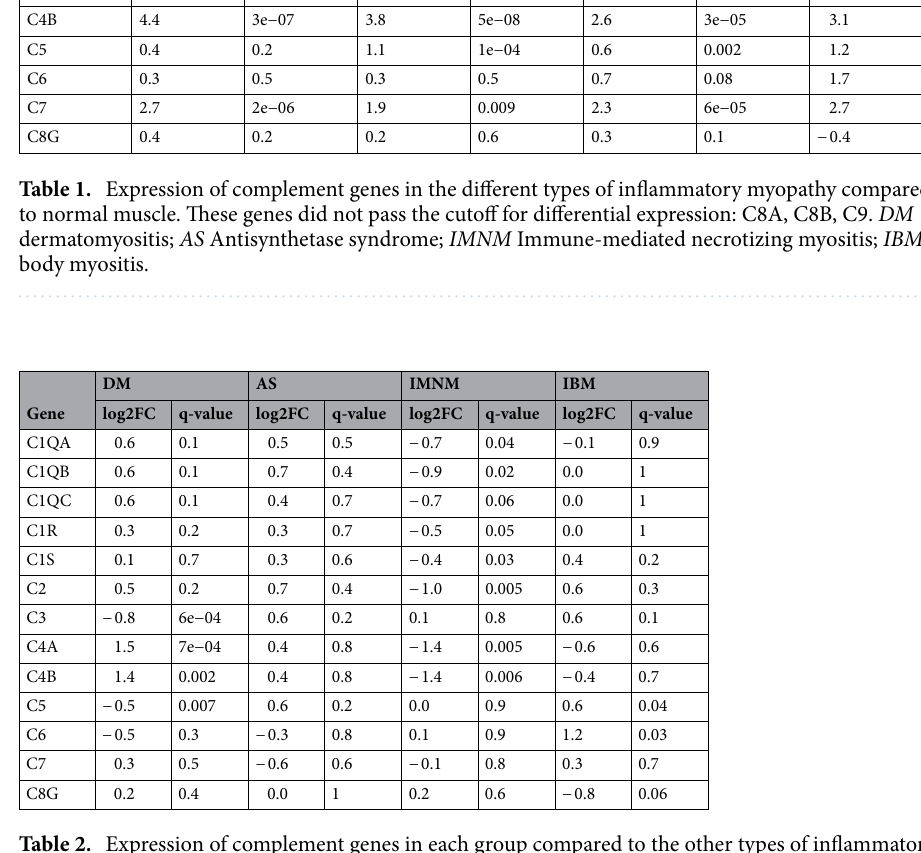
Fig. 5, transcriptomic data from single-nuclei could be used to identify clusters of cells representing mature muscle fibers, satellite cells (i.e., muscle cell precursors), endothelial cells, fibroblasts, T cells, myeloid cells, FAP cells, and adipocytes. Confirming the results of the single-cell experiment, genes encoding C1QA, C1QB, and C1QC were primarily expressed by myeloid cells (Supplementary Figs. 6,7). In contrast, the genes encoding C1R, C1S, and C3 were predominantly expressed by fibroblasts. C1R and C1S were expressed by satellite cells and FAP, albeit at lower levels than in fibroblasts (Supplementary Figs. 6,7).